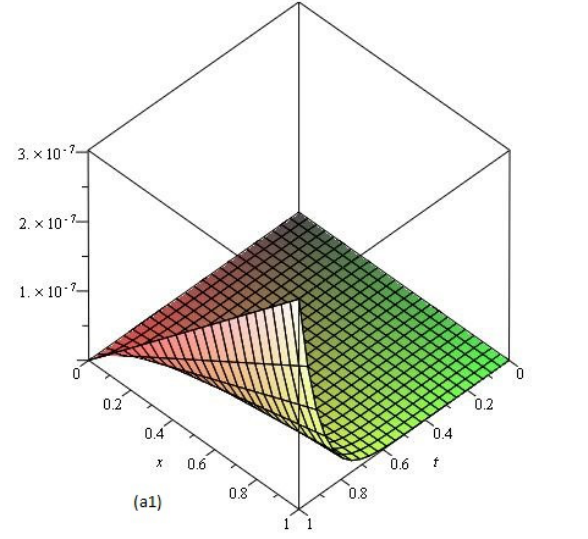
Figure 2. The error plot of Example 1, at γ =